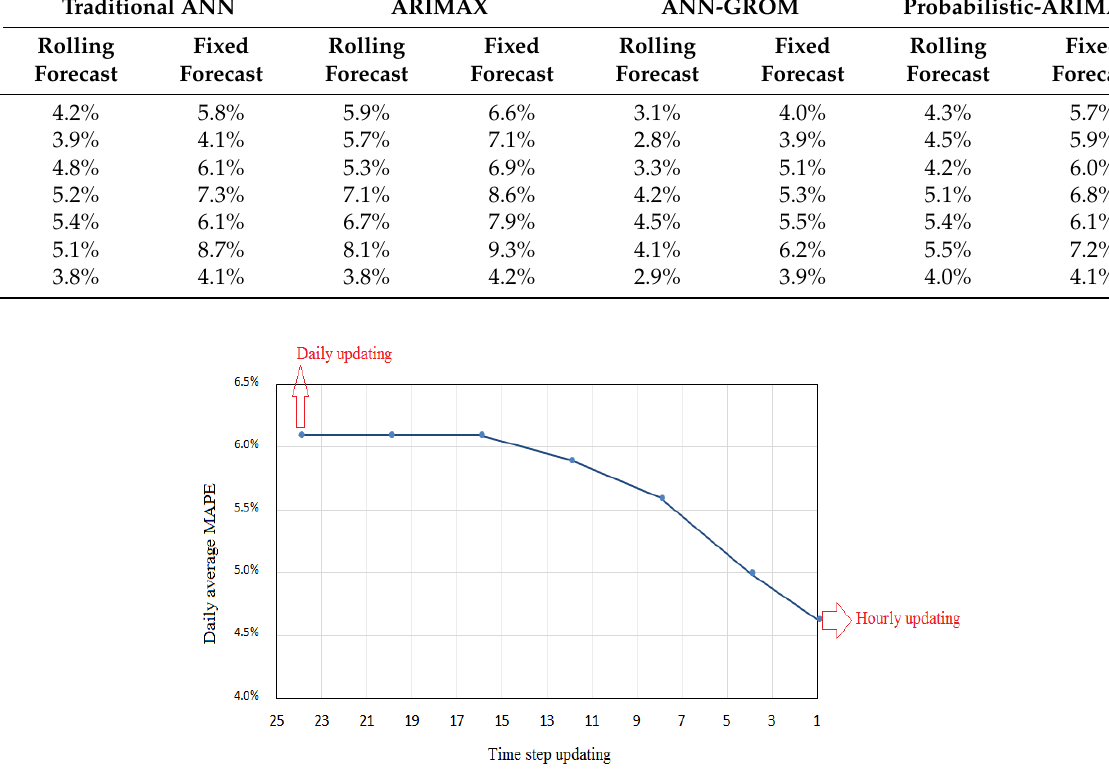
Figure 22. Average of daily MAPE of rolling forecast model with different time step updating.